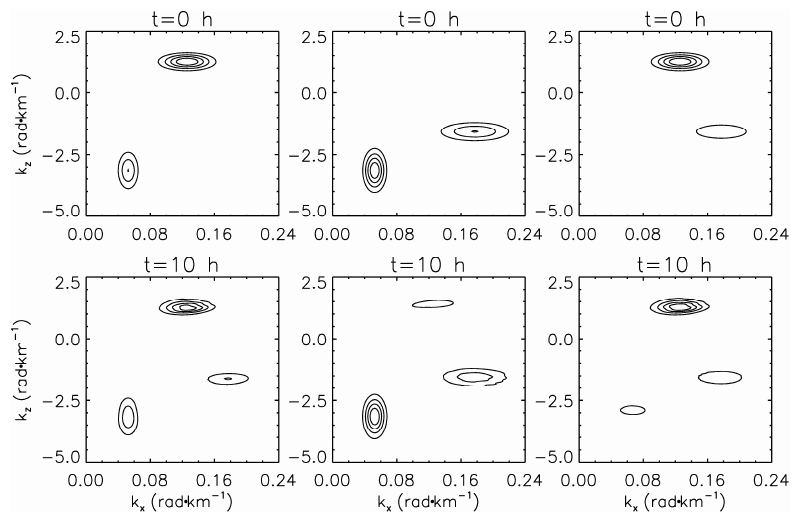
Fig. 8. Similar to Fig. 2, but for cases